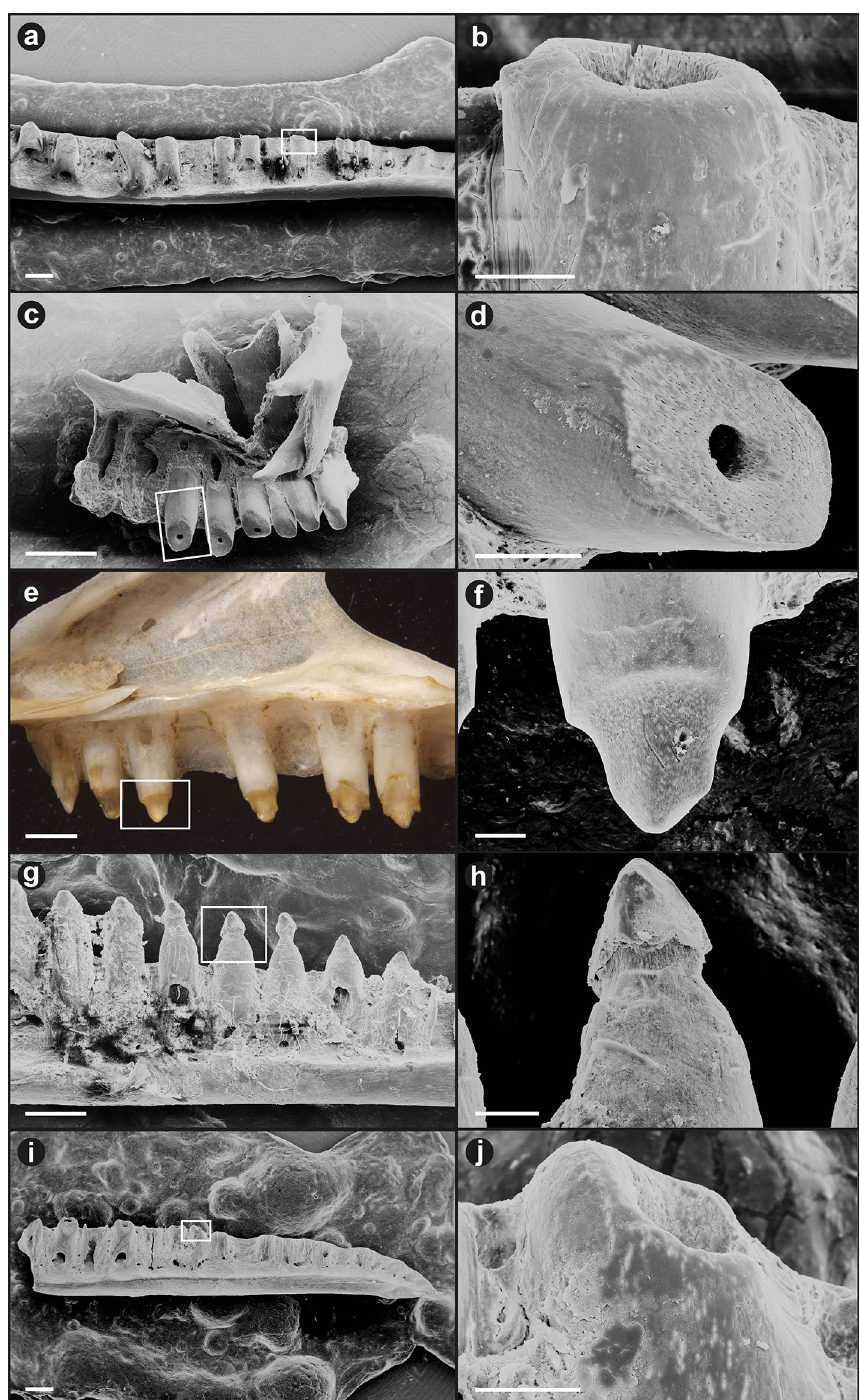
Figure 2. Corrosion damage to teeth of Green Anoles ( Anolis carolinensis ) ingested by Ferrets ( Mustela putorius ). ( a – b ) whole lower jaw and close-up of tooth, where the crown is completely destroyed and the shaft is damaged, exposing small pits; ( c – d ) whole premaxilla and close-up of tooth, where the crown is completely destroyed and the shaft is not damaged; ( e – f ) whole upper jaw and close-up of tooth, where the crown is decalcified (note pin-prick) but the shaft is not damaged; ( g – h ) tooth series from and close-up of tooth crown from lower jaw, showing antero-posterior gradient and ’neck’ corrosion; ( i – j ) whole lower jaw, showing antero- posterior gradient, and close-up of tooth. Scale bars: left panels 0.5 mm, right panels 100